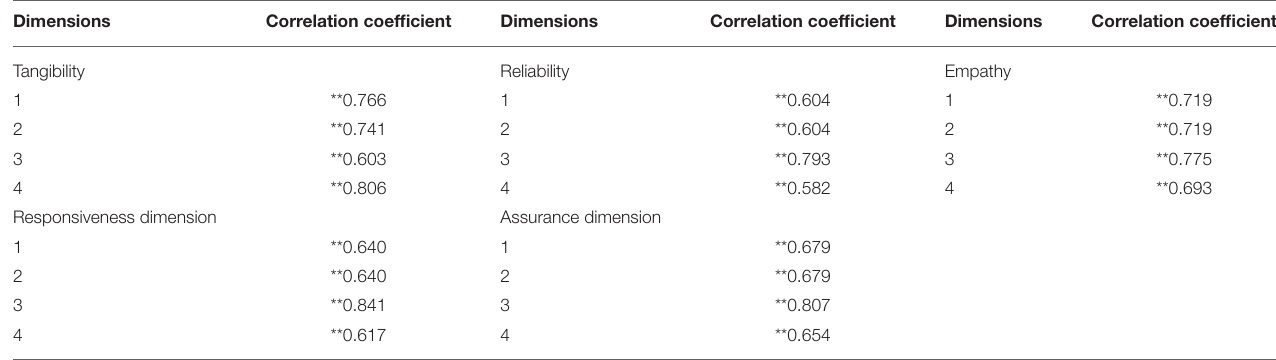
TABLE 2 | Correlation coefficients for each dimension statement with the total degree of the dimension to which it belongs. Dimensions